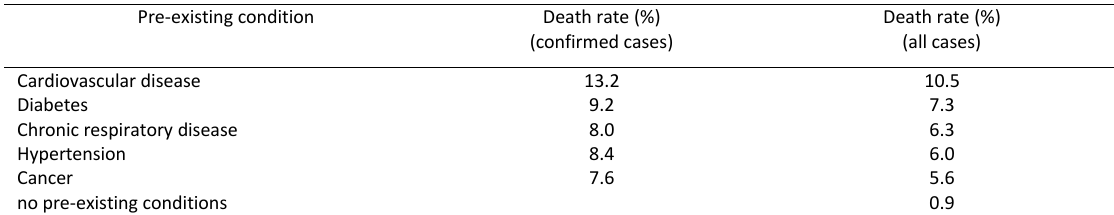
Table 4: COVID-19 mortality rate with pre-existing health conditions (Worldometer, 2020) Pre-existing condition